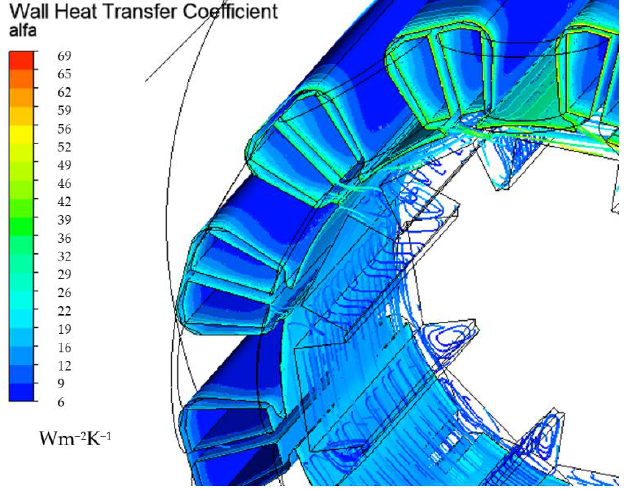
Figure 14. Computational fluid dynamics (CFD) simulation results of the heat transfer coefficient — rotating machine.